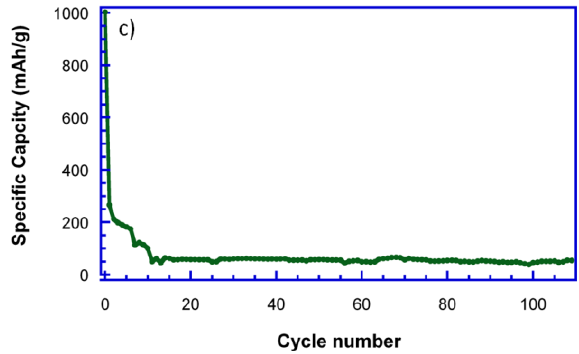
Figure 6. ( a ) Discharge-charge curves, ( b ) cyclic voltammetry (CV), and ( c ) cyclability of NiO_29%C electrode.